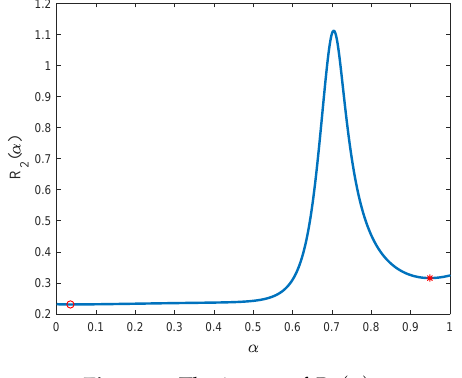
Figure 1. The image of R 2 ( α ) .